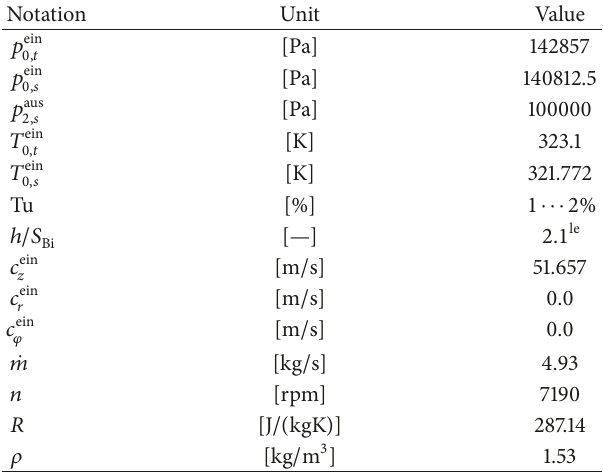
Table 4: The aerodynamic data in the optimal operation